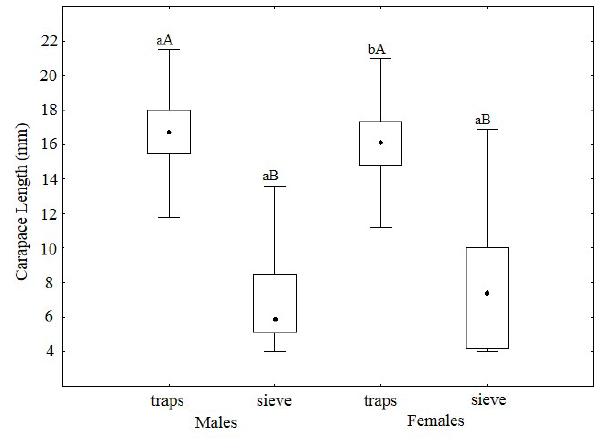
Figure 8. Median size of Macrobrachium olfersii males and females captured by traps or sieves in the sampling area, São Paulo, Brazil. The boxplots show the median: 75% and 25% quartiles; the whiskers indicate the non-outlier range; GLM with a posteriori Sidak test: capital letters compare the sexes by capture method, whereas small caps indicate the comparison of capture methods by sex at